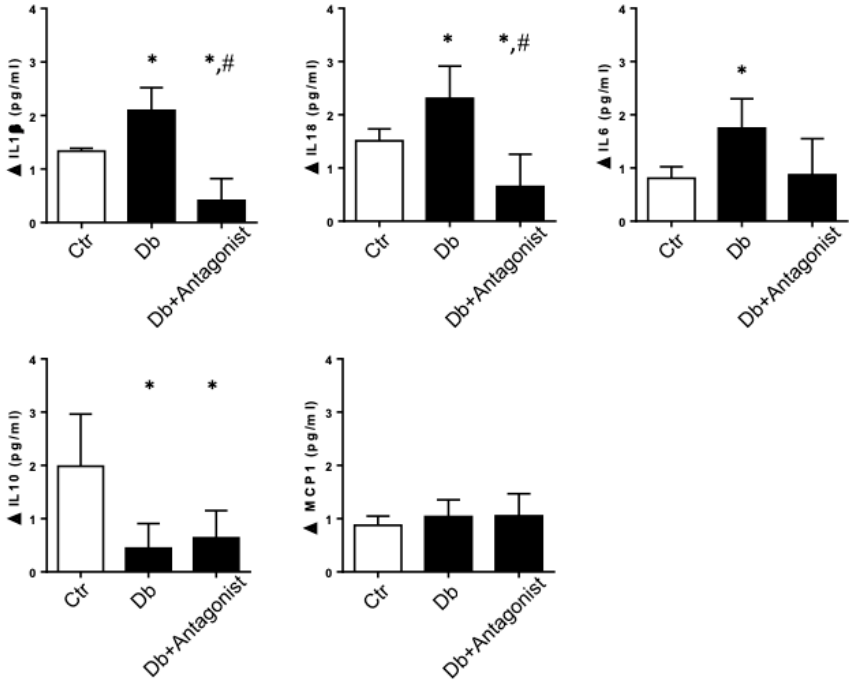
Figure 2. The administration of an antagonist of the ADORA3 decreases IL-1 β and IL-18 in diabetic rats. ADORA3 antagonist or vehicle were administered to diabetic rats for a four weeks period. The levels of the cytokines IL-1 β , IL-18, IL-6, IL-10, and MCP-1 were quantified in urines of rats by using Immunoassays & MILLIPLEX ® map system. The control group (Ctr) corresponded to non-diabetic rats ( n = 5), the diabetic group (Db) corresponded to STZ-induced diabetic rats treated with vehicle ( n = 5) and the diabetic treated group (Db + Antagonist) corresponded to STZ-induced diabetic rats that